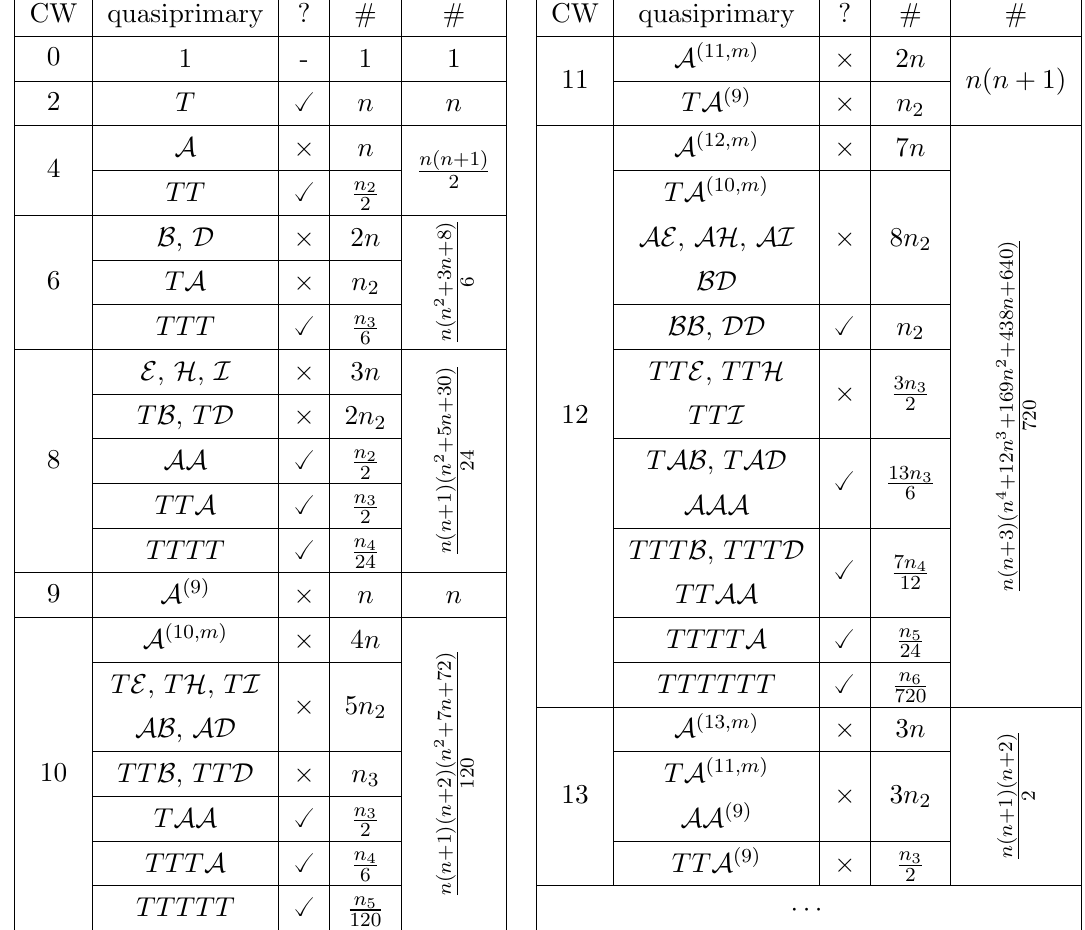
Table 3 . The CFT n holomorphic quasiprimary operators that are direct products of the vacuum conformal family holomorphic quasiprimary operators in each copy of the original CFT. We use CW to denote the conformal weight. We have omitted the replica indices for these operators. For example, at conformal weight 8, TT A denotes T j j 1 6 = j 3 , j 2 6 = j 3 . In the third column, we mark vanishing contributions to the single interval EE in a translation-invariant state, i.e. with non- vanishing coe(cid:14)cients a K de(cid:12)ned in (B.15), and we mark × for operators with vanishing